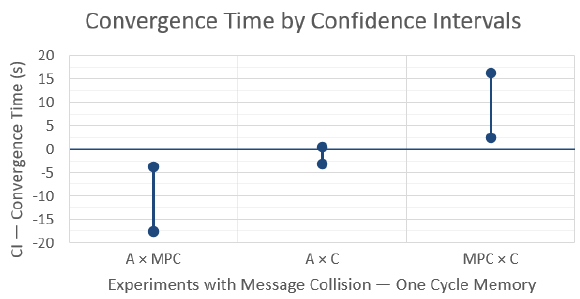
Figure 4. Differences in convergence time between the rendezvous techniques with 99% confidence intervals and message losses, with one communication cycle memory.